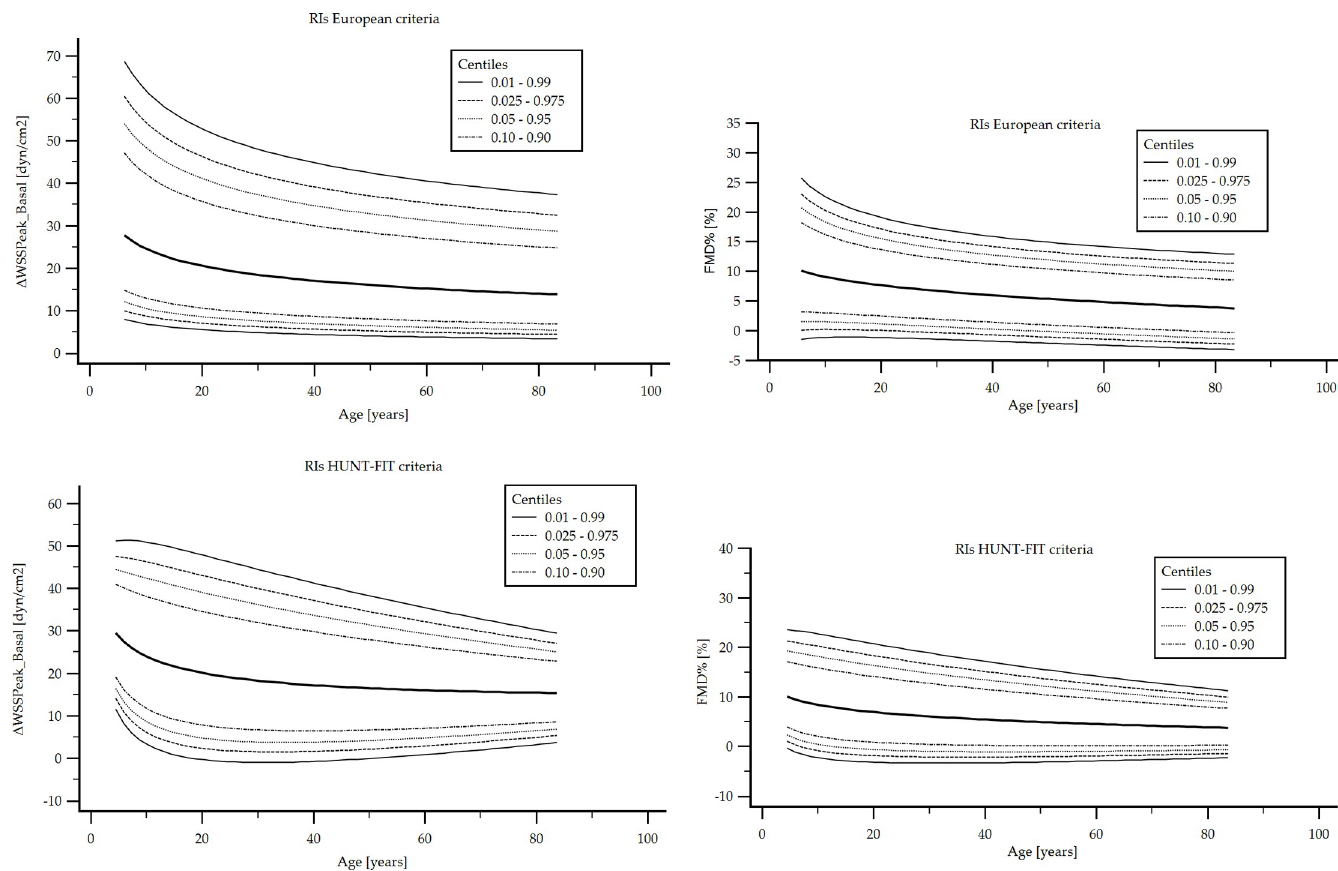
Fig 9. FMD% (top) and Δ WSS Peak_Basal (bottom) age-related profiles or percentile curves for European (left) and HUNT-FIT (right) criteria. Quantitative data is in Table 6 and S1 File.